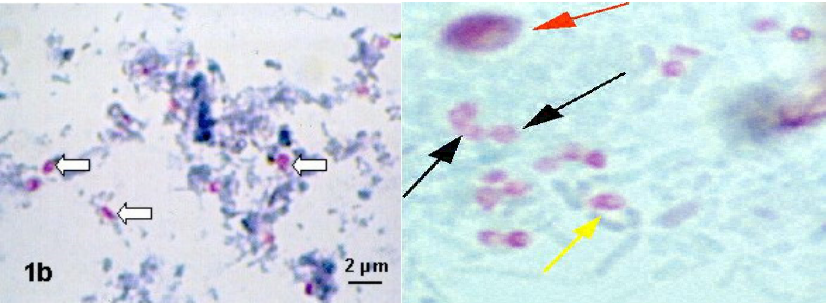
Figure 4. Modified chromotropic staining methods: Weber-Green and Ryan-Blue. Spores (arrows) are pinkish-red, with a light interior of the spore, or possibly with horizontal or diagonal stripes [51]. 6.1. Microscopic Methods in the Diagnosis of Nosema Spp.